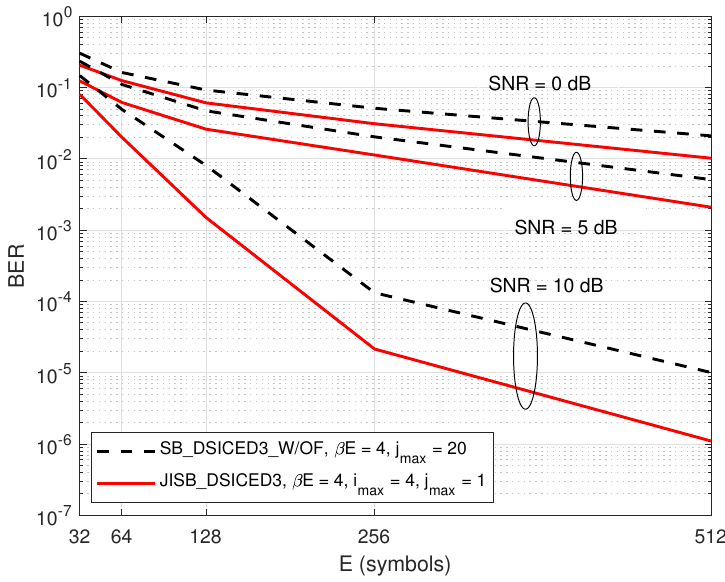
Figure 12. BER versus E; R = 1/2, β E = 4, i max = 4, and p SI / σ 2 w = 30 dB.